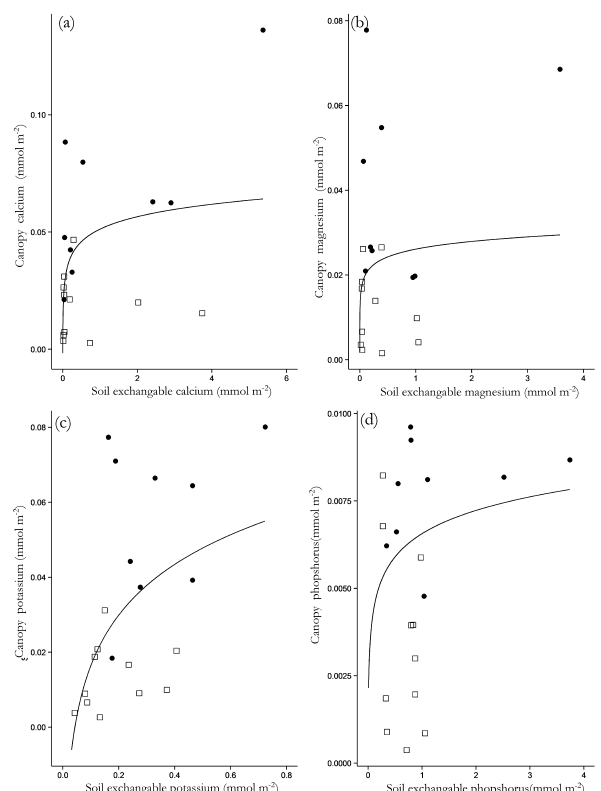
Figure 8. Relationships between soil and community-abundance- weighed foliar nutrient concentrations with both expressed on a ground area basis. (a) Calcium, (b) magnesium, (c) potassium and (d) phosphorus. ( • ) Forest plots; ( (cid:3) ) savanna plots. The curves shown are log-linear, viz. y = a + b log (x) , fitted using a robust non- parametric